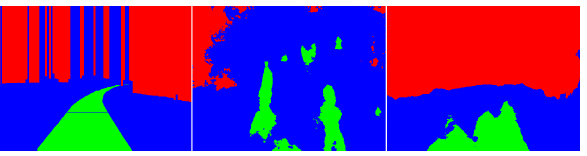
Figure 7: Groundtruth of a test image from the WEpod dataset(left). The same test image predicted through the baseline method (middle) and the output of our network when the order of training is changed in the setup